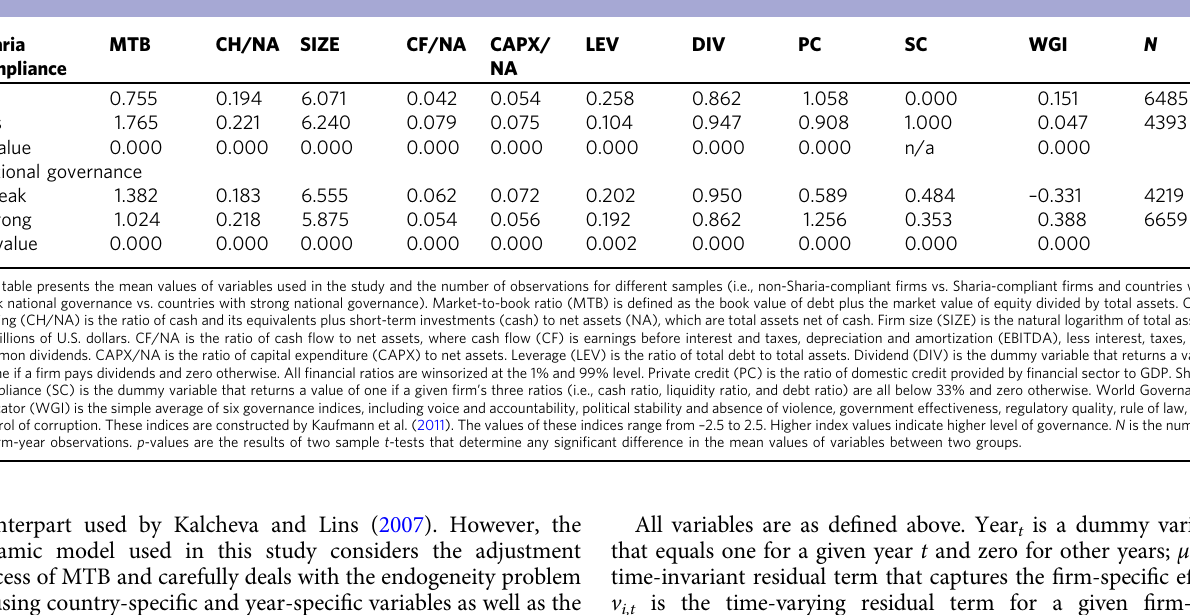
Table 2 Descriptive statistics for different groups of fi